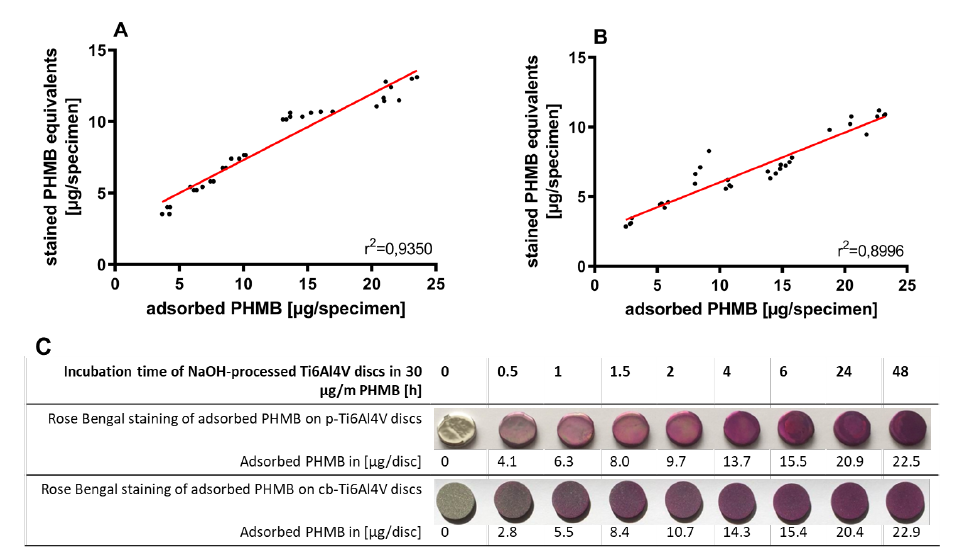
Figure 6. PHMB adsorption after incubation of test specimen in 5M NaOH at 60 ◦ C and staining with Rose Bengal for 20 h. The amount of bound PHMB is rising with increasing incubation time in the PHMB solution but is not dependent on surface roughness. ( A ) PHMB adsorption on polished test specimen, incubated in NaOH for 2 h before. ( B ) PHMB adsorption on corundum-blasted test specimens incubated in NaOH for 1 h before. ( C ) Amounts of adsorbed PHMB [ µ g/specimen] of NaOH-processed p- and cb-Ti6A4V discs after different incubation times in 30 µ g/mL PHMB-coating solution and the corresponding Rose Bengal-stained surfaces to monitor PHMB.